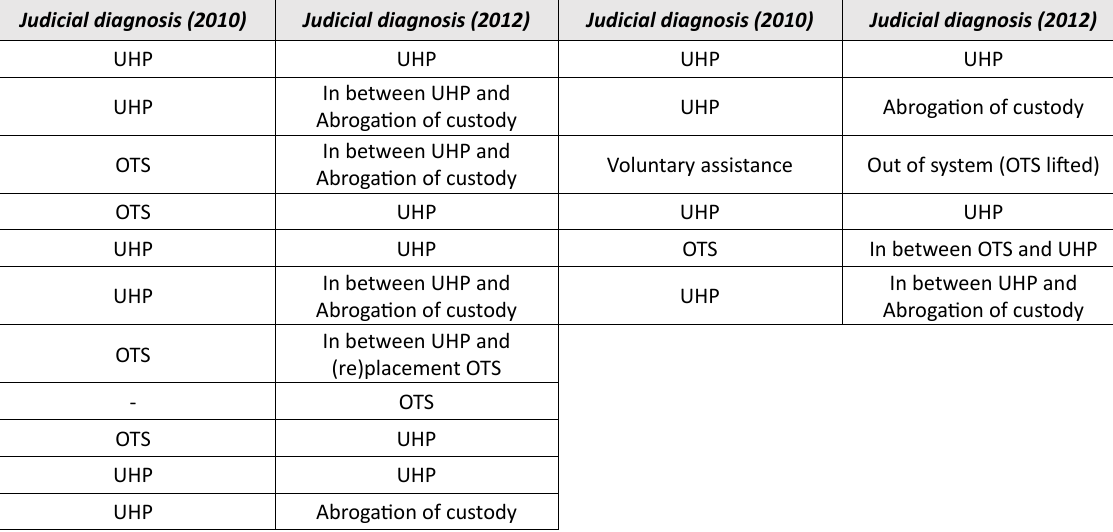
Judicial diagnosis: Dutch (N=11) versus Dutch-Curaçaoan (N=6) families in 2010 and 2012. Judicial diagnosis (2010) Judicial diagnosis (2012)